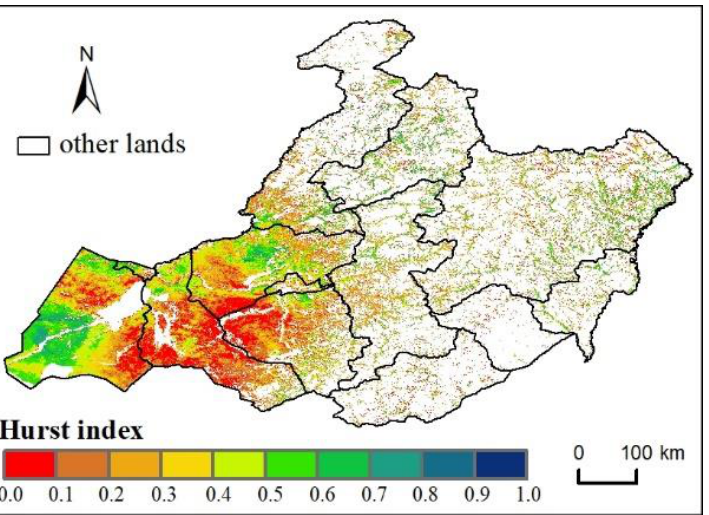
Figure 8. Spatial distribution of the Hurst index in Hulunbuir grassland from 2008 to 2020.